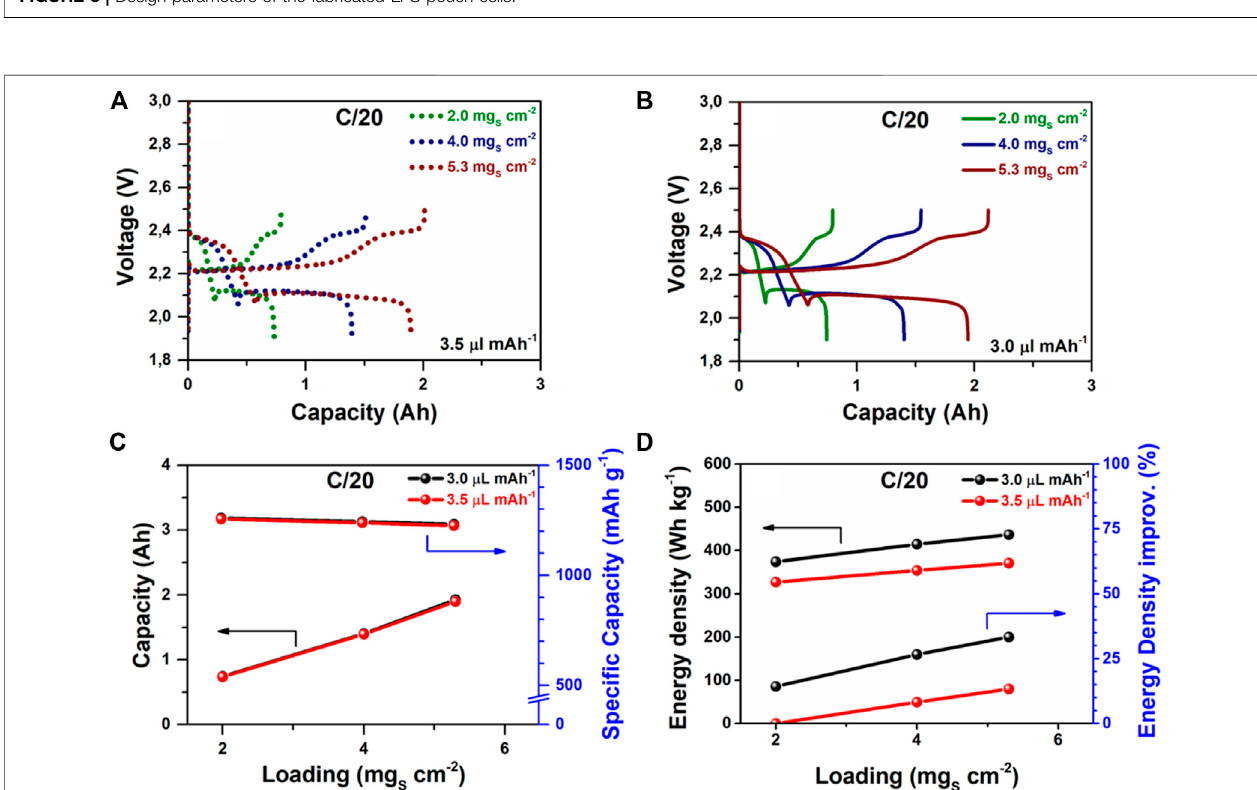
FIGURE 4| Electrochemicalperformance ofLi-S pouch-cellswith different ASL (2.0, 4.0, and 5.3 mg s cm − 2 ) and at different E/C ratios (3.0 and 3.5 µl mAh − 1 ) at a current density of C/20. Galvanostatic charge/discharge pro fi les of Li-S batteries with (A) 3.5 µl mAh − 1 and (B) 3.0 µl mAh − 1 . (C) Capacity and speci fi c capacity